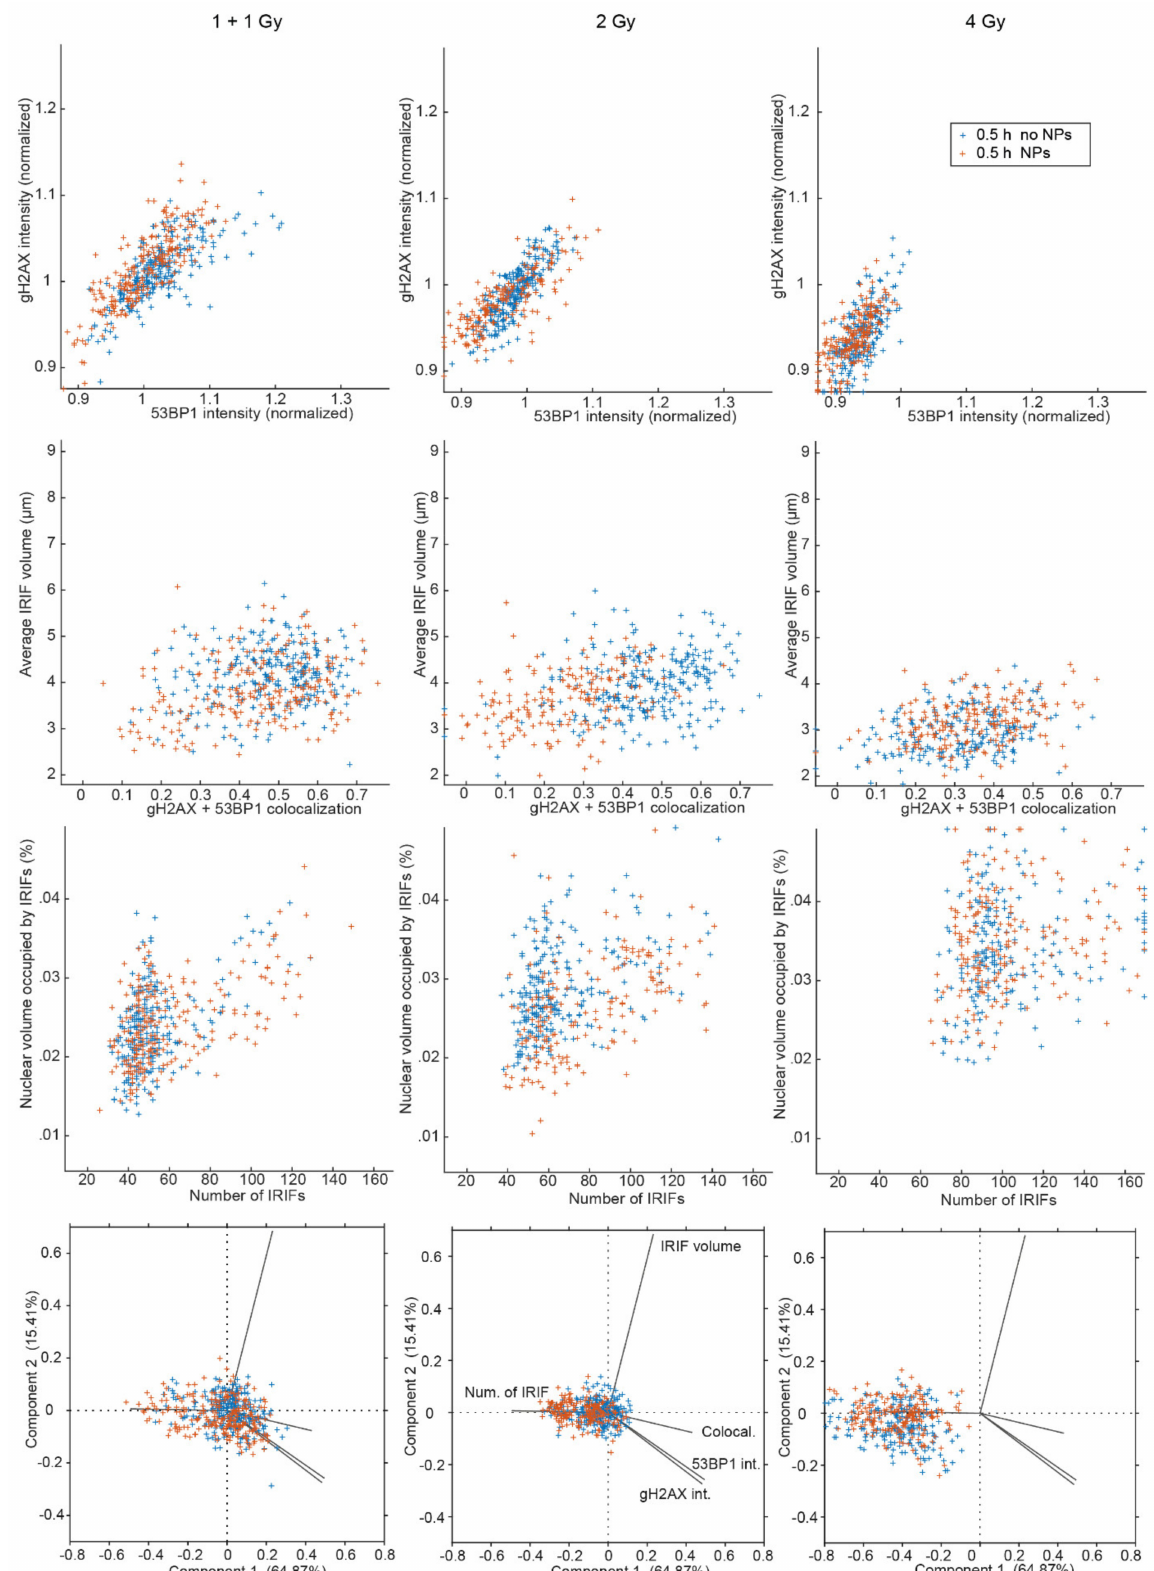
Figure 7. Correlations and principal component analysis (PCA) of multiple γ H2AX and 53BP1 repair focus parameters compared for GNP( − ) ( blue ) and GNP(+) (0.4 µ g/mL, orange ) SkBr3 cells irradiated with indicated doses of γ -rays and analyzed at 0.5 h PI. See the main text for